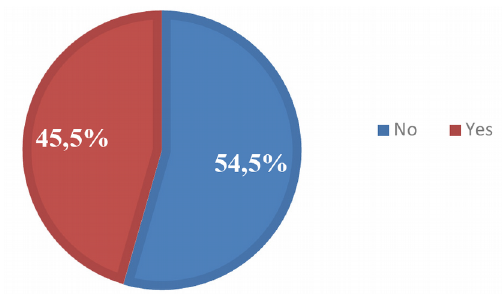
Figure 6. Experiences in implementing STEM in the physics classroom